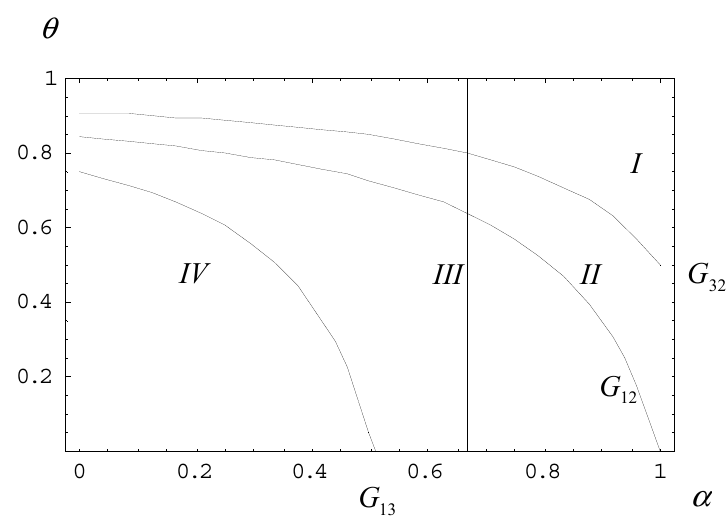
Figure A1. Decomposition of 𝛼 , 𝜃 space for 𝑐 (cid:3039) 𝑐 (cid:3035) ⁄ = 0.2